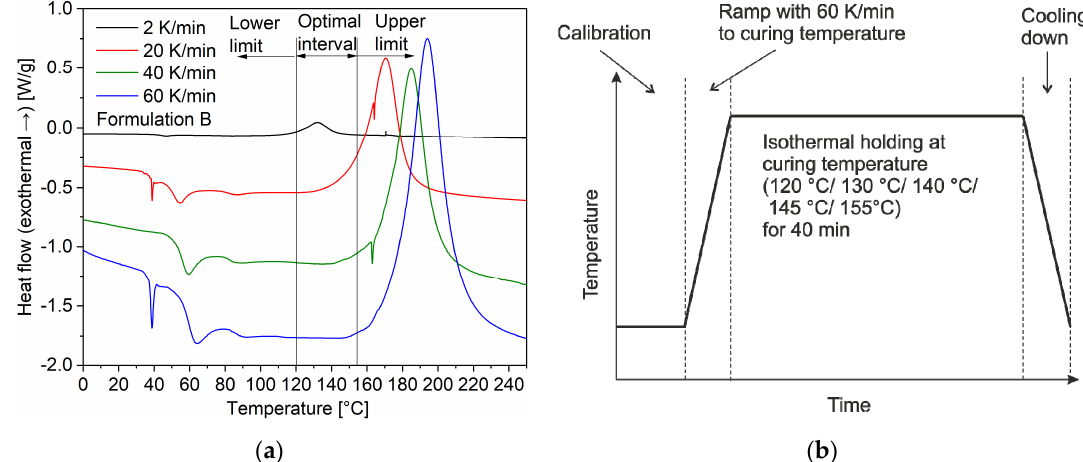
Figure 5. ( a ) The optimal interval of isothermal holding temperature (120–155 °C) was determined by several dynamical DSC measurements, ( b ) Isothermal DSC measuring program.